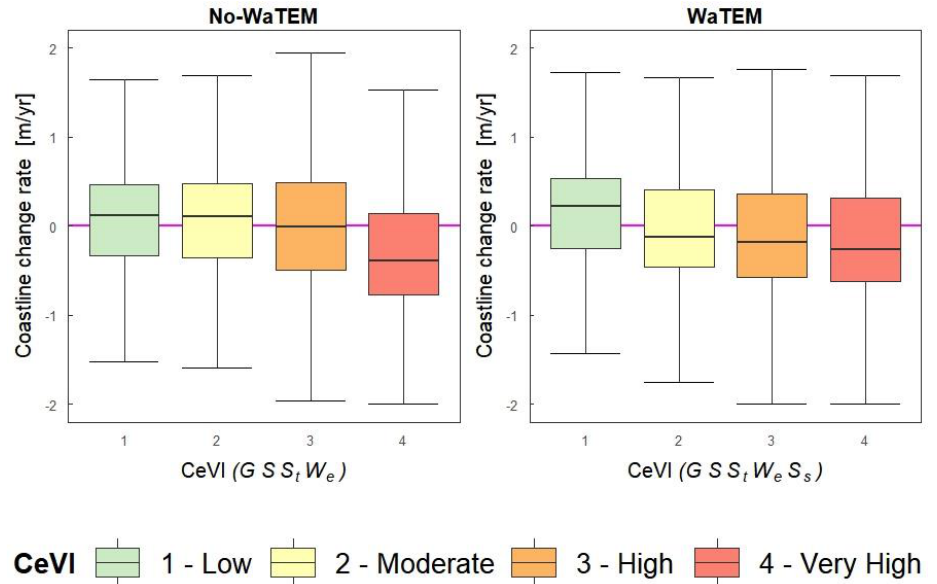
Figure 6. Boxplot for No-WaTEM and WaTEM models. The first shows a median value decrement of the CCA values corresponding to the CeVI classes 3 e 4. The second shows a decrement median value of the CCA for all the CeVI classes.